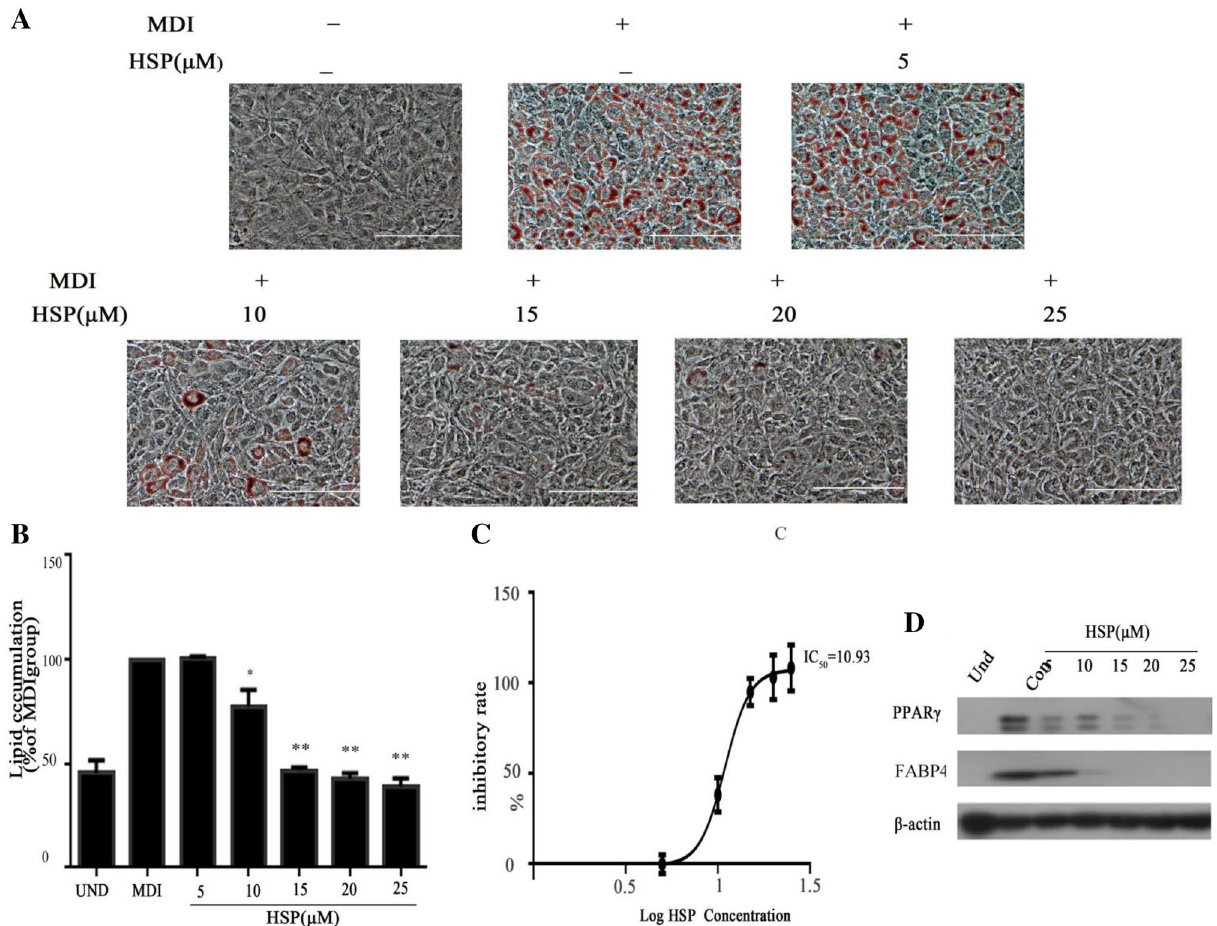
Fig. 3 Hypersampsone P inhibited adipogenesis dose-dependently. a Representative images of 3T3-L1 adipocytes treated with a series of doses of hypersampsone P (5 to 25 µM) and stained by Oil Red O afterwards. Scale bars, 100 µM. b Normalized lipid content by meas- uring Oil Red O intensity of the cells from a . c The dose–response